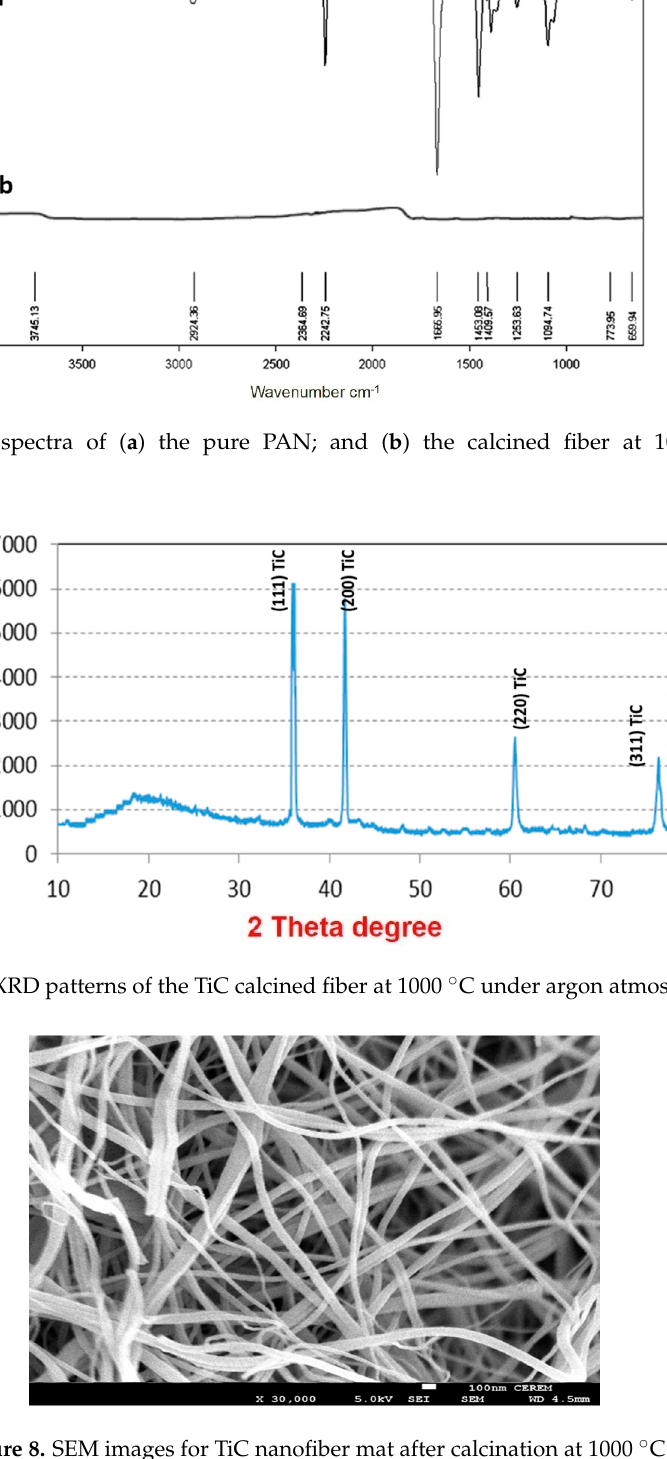
Figure 8. SEM images for TiC nanofiber mat after calcination at 1000 °C.